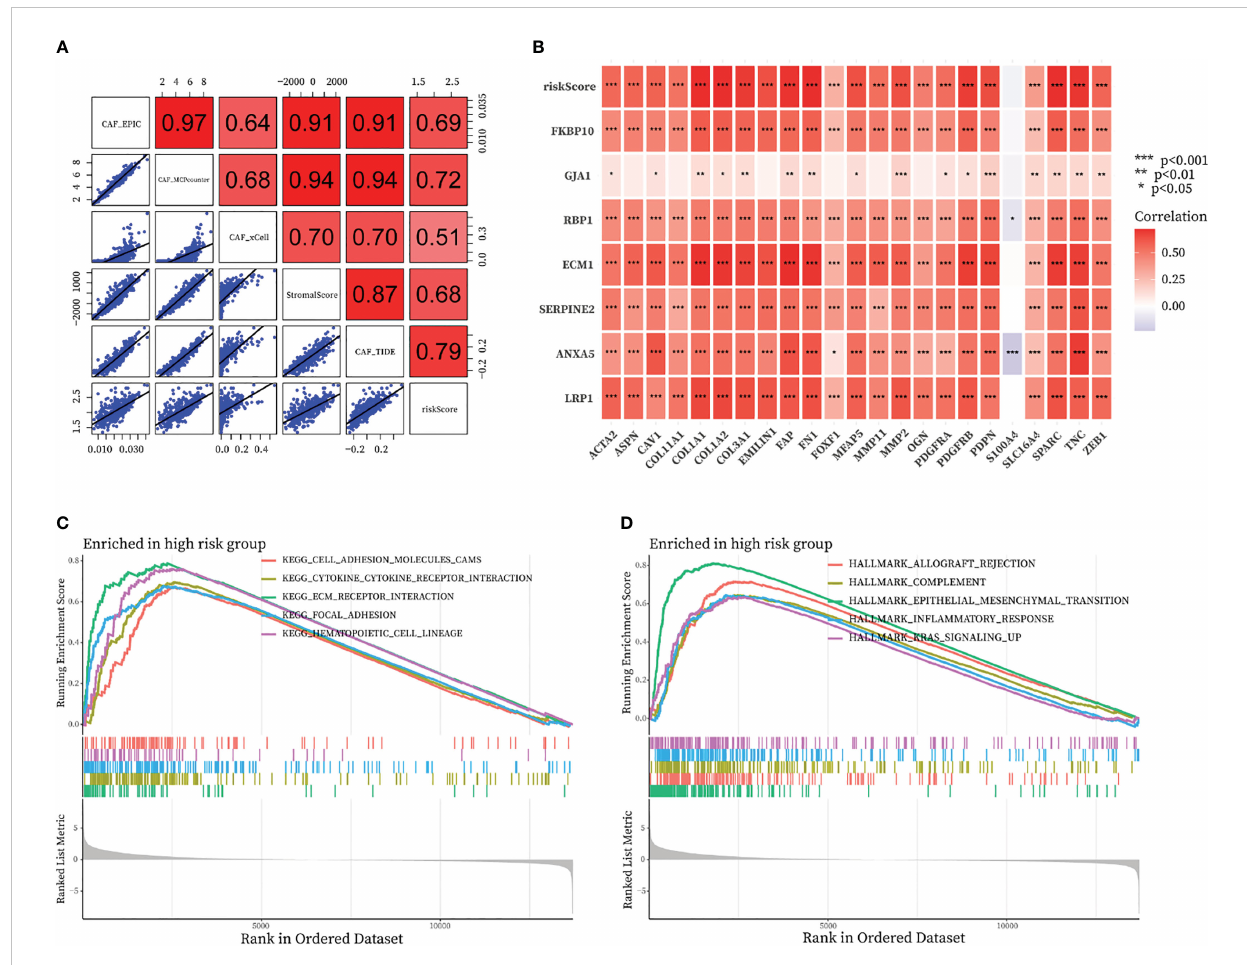
FIGURE 10 Relationship of the fraction of CAF with CAF-signature and results of GSEA analysis in TCGA cohort. (A) Correlation analysis between CAF-riskScore and CAF in fi ltration based on EPIC, xCell, MCPcounter, ESTIMATE, and TIDE algorithms. (B) Relationship between know CAF related gene expression and the expression of the CAF-riskScore and seven CAF-signature component gene. (C, D) GSEA analysis of high CAF-risk subtype based on (C) KEGG gene sets and (D) hallmark gene